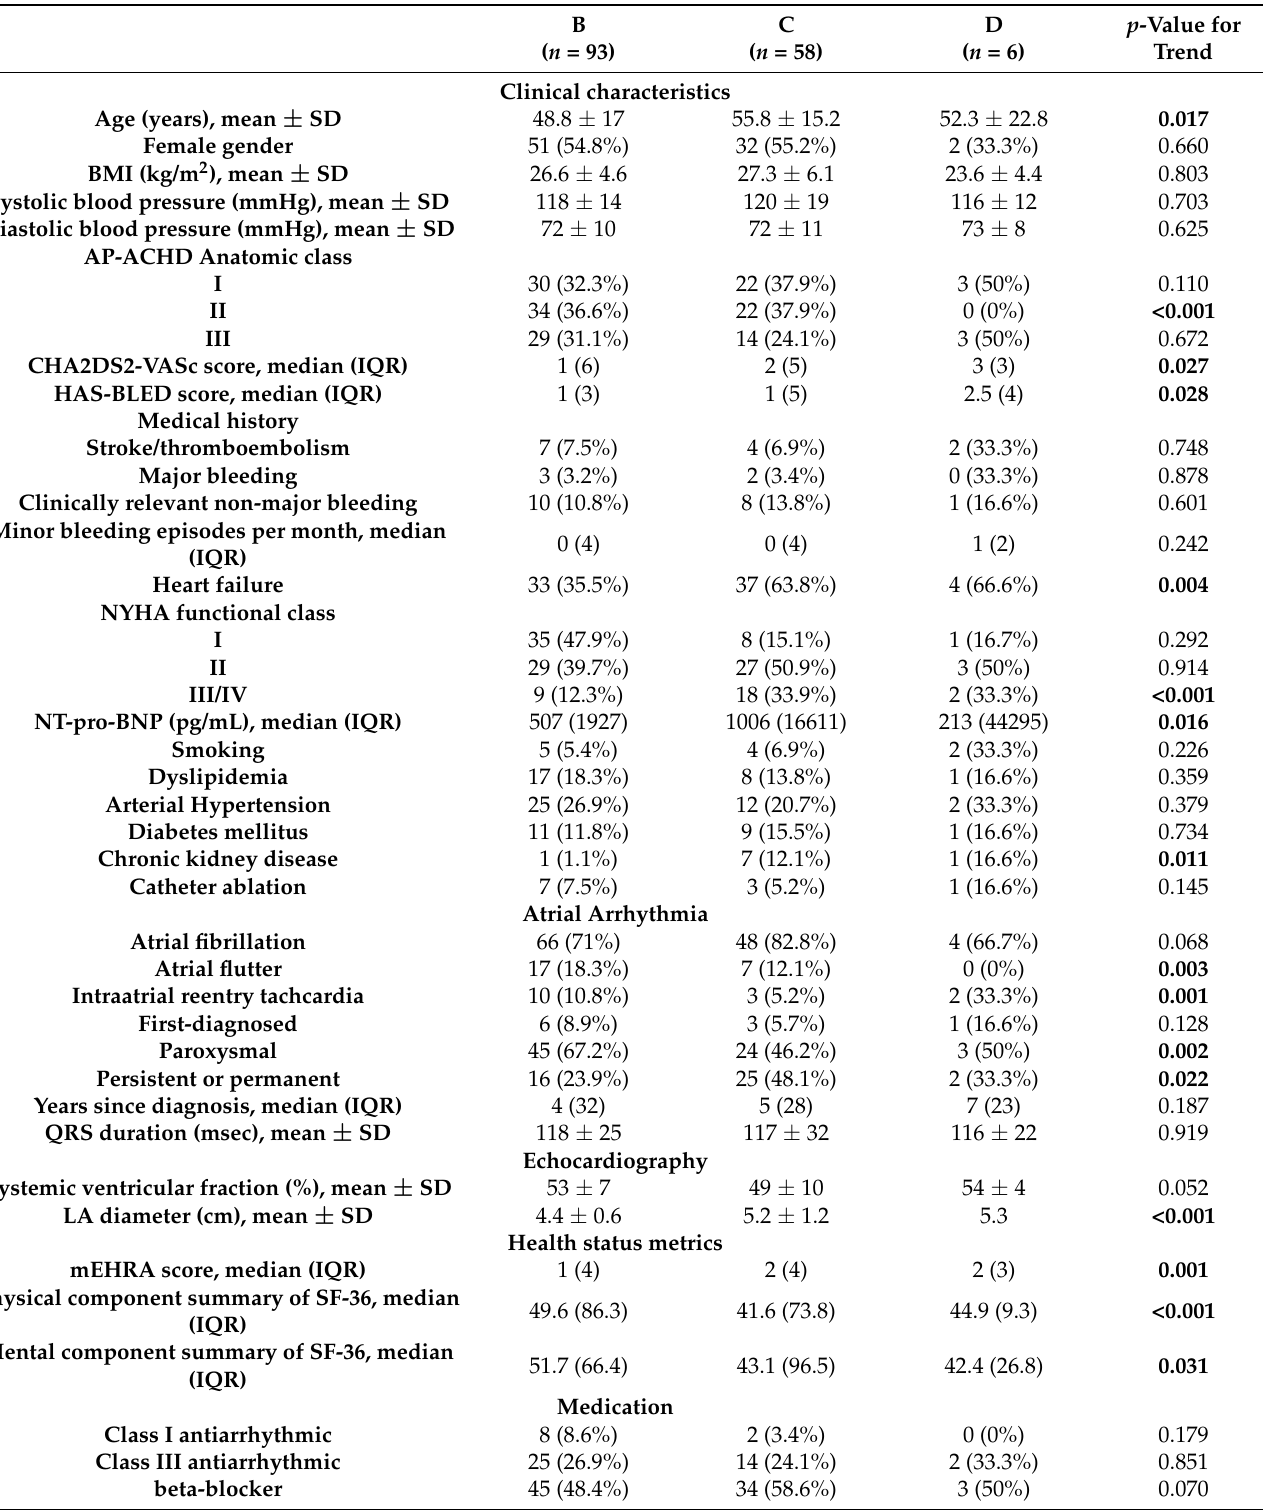
Table 2. Descriptive and Clinical Characteristics by Physiological